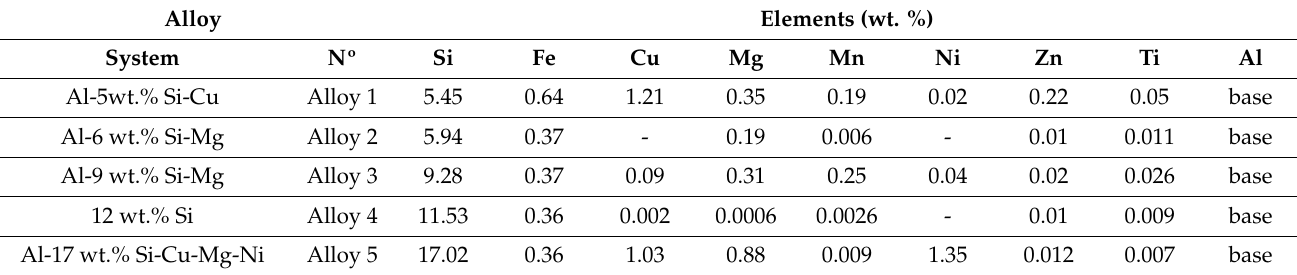
Table 1. Elemental composition of the study alloys according to spectral analysis data (average values). Alloy Elements (wt. %) System Al-5wt.% Si-Cu Al-6 wt.% Si-Mg Al-9 wt.% Si-Mg 12 wt.% Si Al-17 wt.%